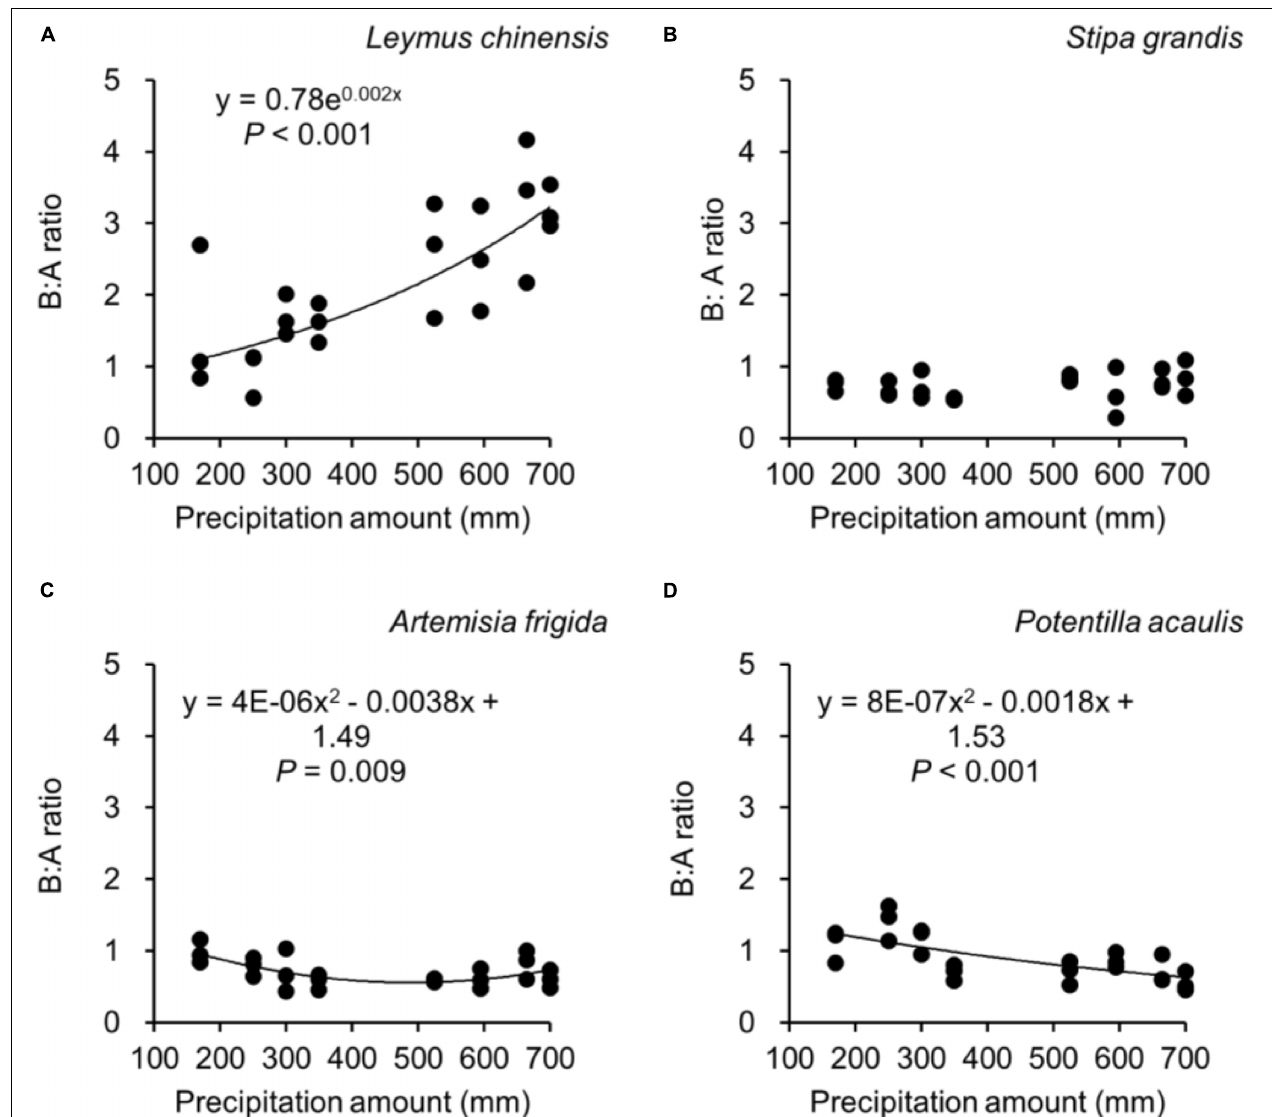
FIGURE 5 | At the pot scale, regressions between precipitation amount and B:A ratio (i.e., ratio of belowground biomass and aboveground biomass), separately for (A) Leymus chinensis , (B) Stipa grandis , (C) Artemisia frigida , and (D) Potentilla acaulis , where each dot refers to a B:A ratio from a